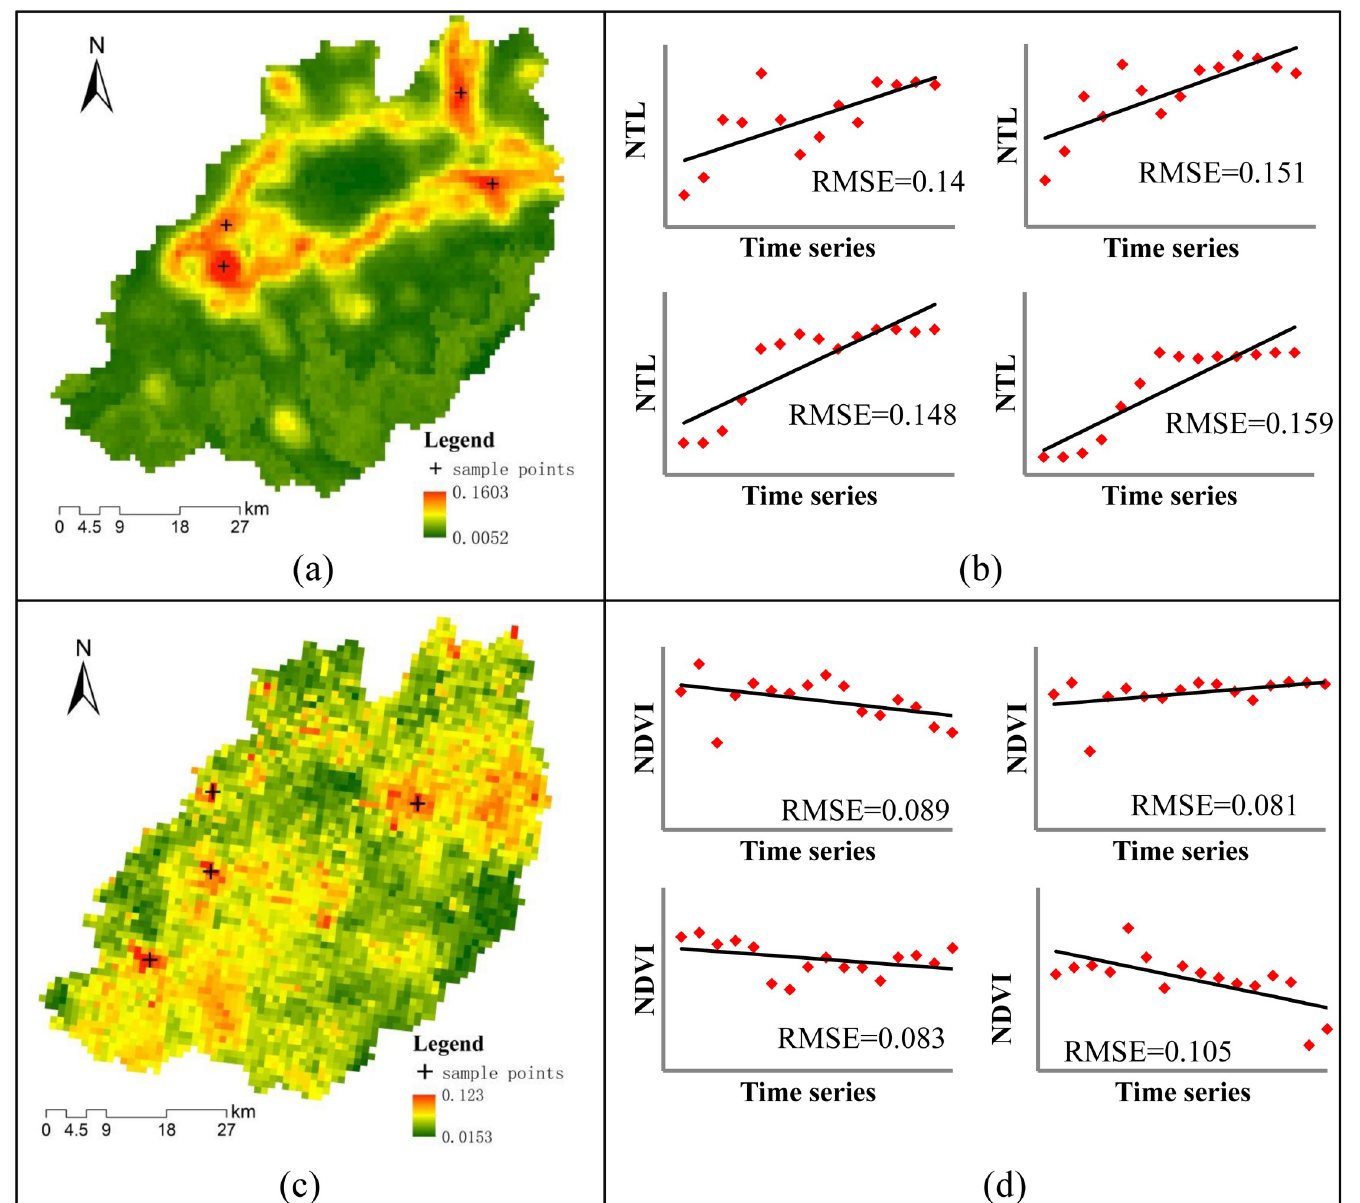
Fig 4. The linear fitting goodness evaluations of NTL and NDVI time series. (a) the RMSE map of the NTL time series; (b) examples of NTL linear fitting at sample points with high RMSE values; (c) the RMSE map of NDVI time series; (d) examples of NDVI linear fitting of sample points with high RMSE values.